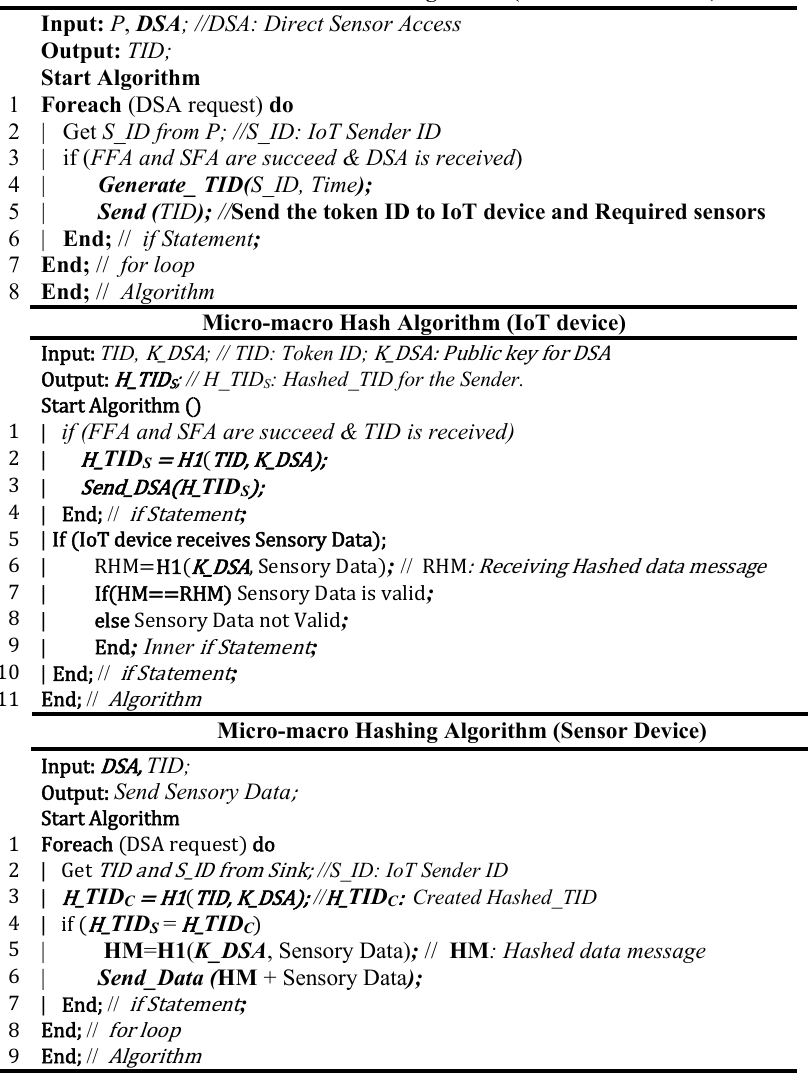
Micro-macro Hash Algorithm (Base station Device